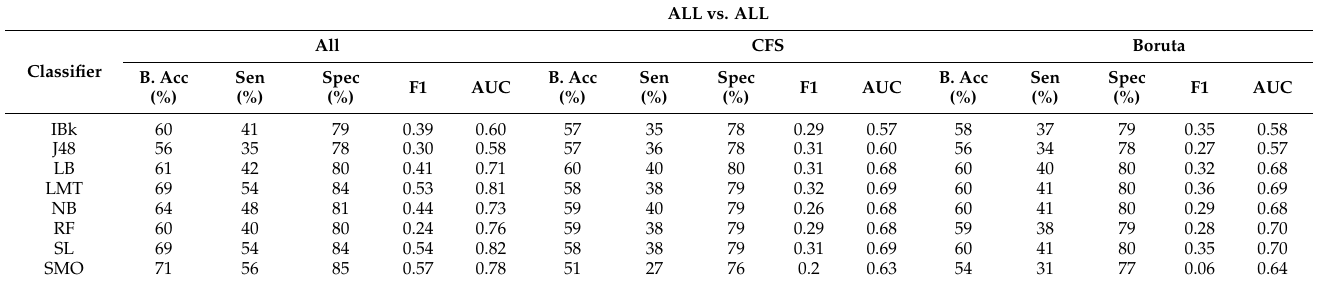
Table 2. Mean balanced accuracy, sensitivity, and specificity (across the 100 MCCV repeats) for ALL vs. ALL disease combinations for all 9 classifiers using all features, CFS, and Boruta methods. ALL vs.